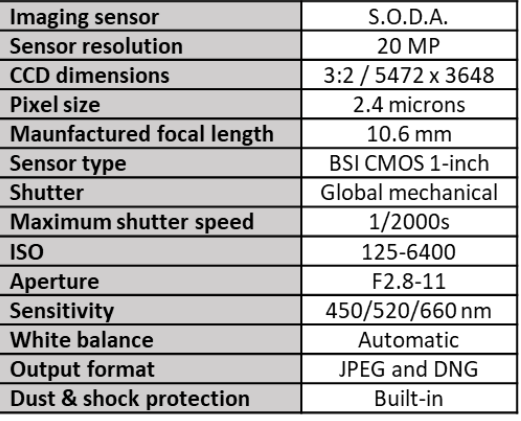
Table 2. Sensefly eBee UAS platform hardware specifications.